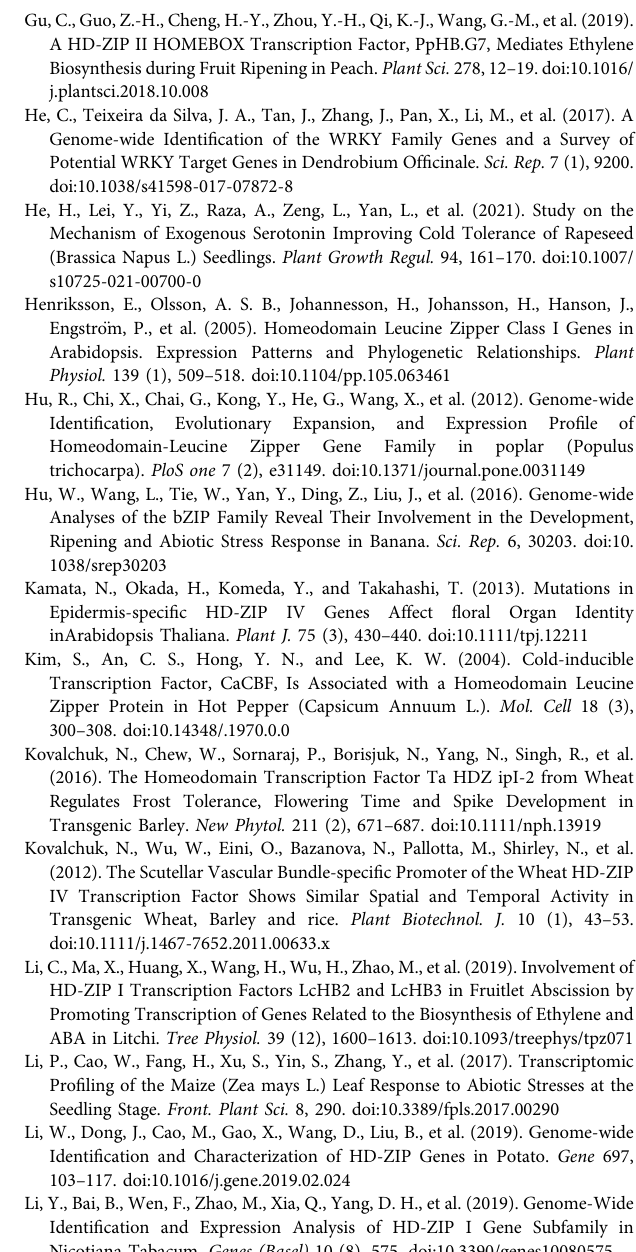
Supplementary Figure 1 | Tissue-speci fi c expression analysis of HD-ZIP genes in D. of fi cinale . Tau was calculated by Yanai et al. (2005). Tau varies from 0 to 1, where 0 means broadly expressed and 1 is speci fi c. Supplementary Figure 2 | WGCNA analysis of the HD-ZIP genes and other genes based on the expression levels in nine different tissues and under cold stress in D. of fi